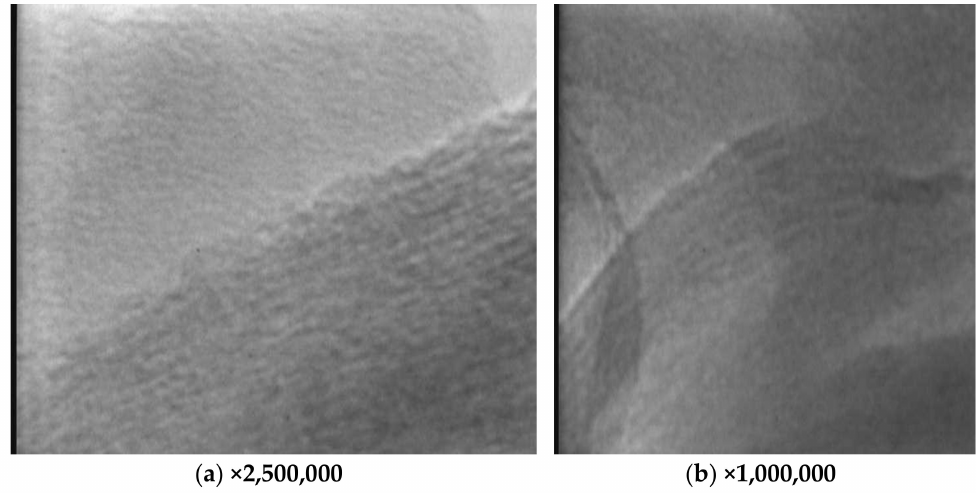
Figure 14. TEM micrographs of CLOISITE ® clay 20 A ( a ) and PACN ( b